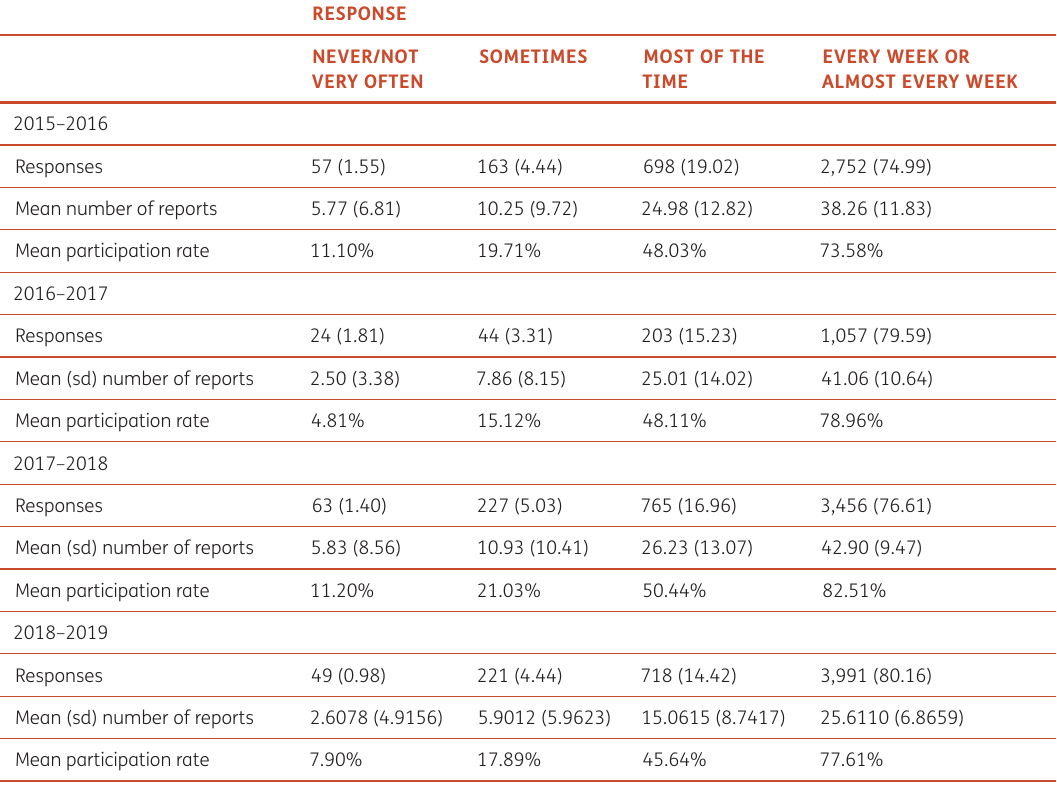
Table 4 Number of responses to the question “How often do you report to Flu Near You?” Mean number of reports out of 52 1 and mean participation rate 2 for survey respondents for four influenza seasons. Number of responses is reported as n (%), and average number of reports is presented as mean (standard